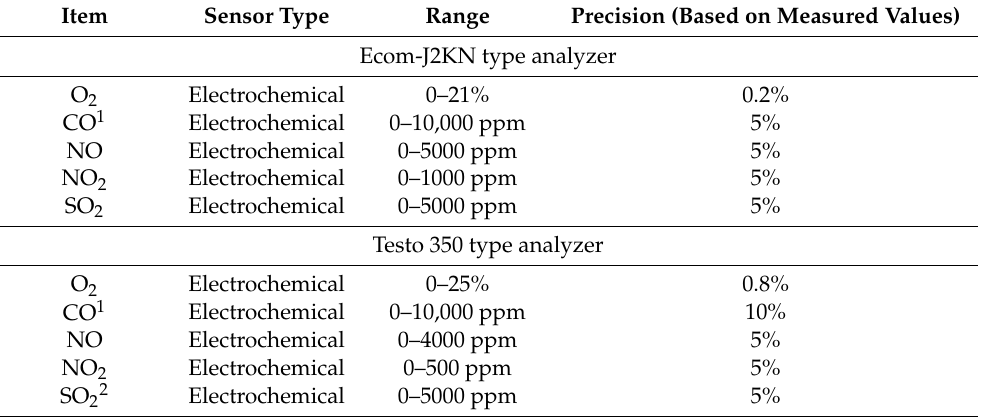
Table 2. Information of the two gas analyzers used in the